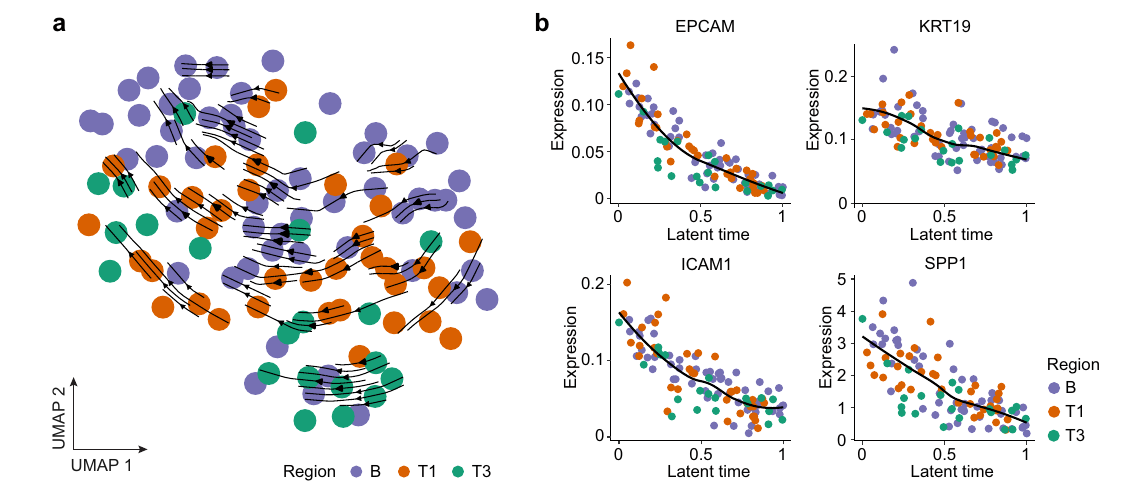
Fig.2|Multiregionaltumorcelltrajectoryofcase1C.a RNAvelocityofmalignant cells from all tumor regions with viable malignant cells. b Expression of EPCAM,